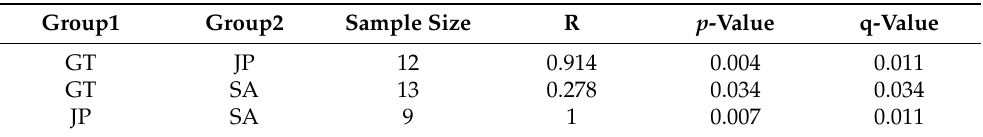
Table 2. Anosim was used to verify difference between bare flats (GT), Sueada salsa areas (JP), and S. alterniflora Loisel areas